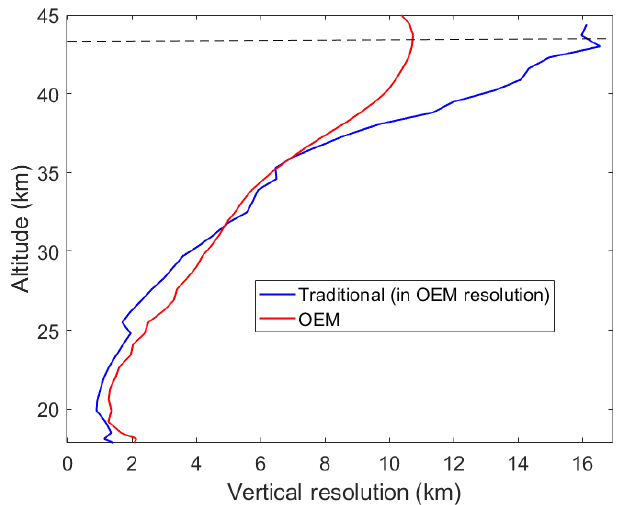
Figure 6. At a height from 20 to 40km, the uncertainty of retrieval for the traditional method (assuming that it has a vertical resolution similar to the OEM vertical resolution) is plotted against the OEM retrieval uncertainty (blue curve: OEM; red curve: traditional).